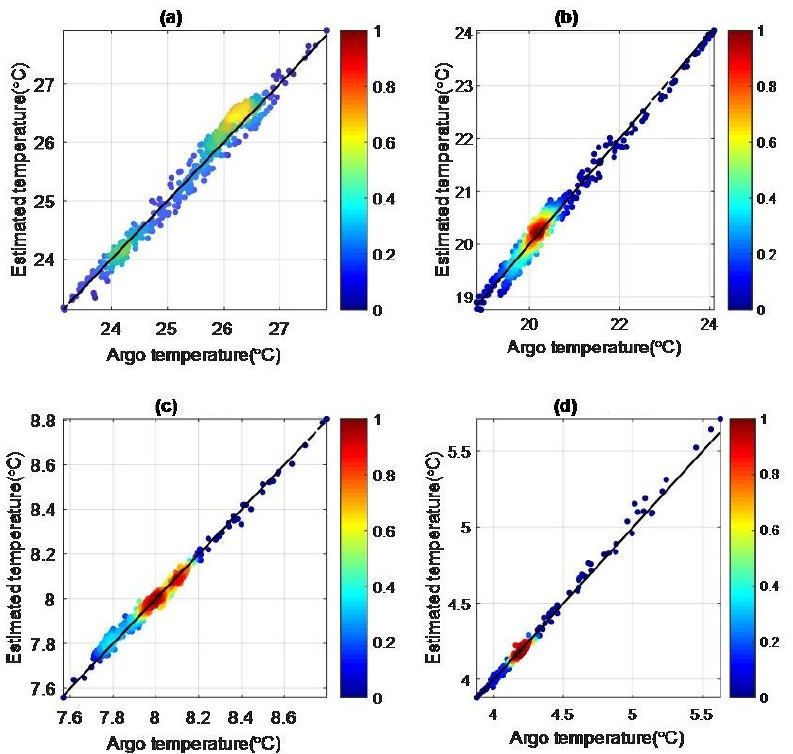
Figure 9. Scatter plots of temperature from the Ens-ML estimation and Argo observations at ( a ) 50 m, ( b ) 100 m, ( c ) 500 m, and ( d ) 1000 m in 2019. The data pairs are color-coded by data density at each temperature interval of 0.2 °C.